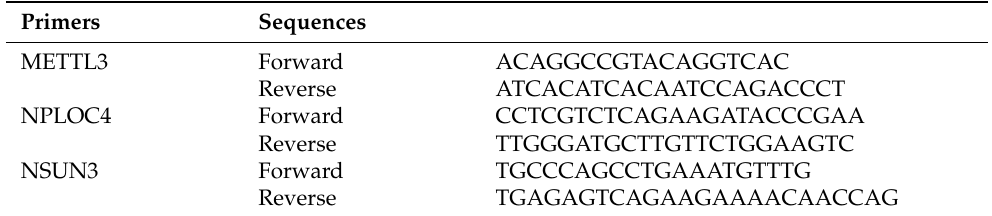
Figure 8. The mRNA expression of seven risk genes. ( A ) The different mRNA expression of seven risk genes between paired tumor and normal samples in early-stage TCGA-LUAD. ( B ) RT-qPCR analyses seven risk genes expression in paired tumor tissues and paracancerous tissues of LUAD.